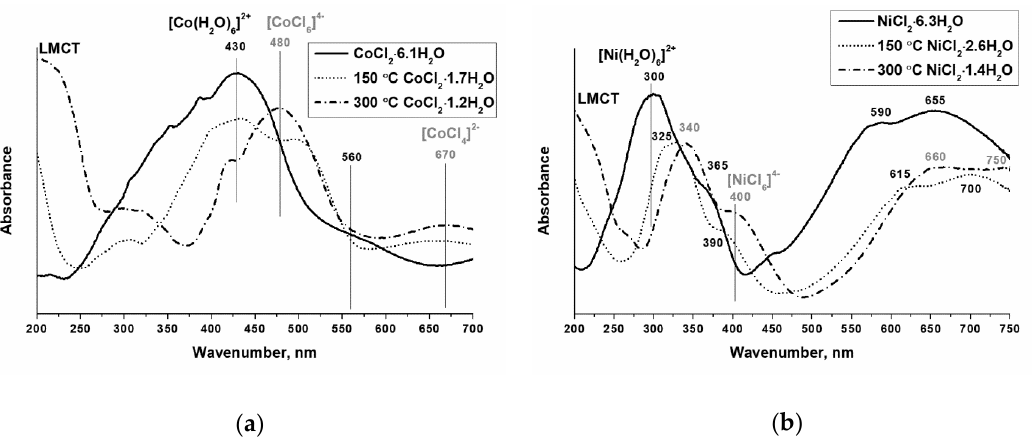
Figure 3. UV-vis spectra of ( a ) cobalt chloride hydrate and ( b ) nickel chloride hydrate, as well as of their partially dehydrated species.